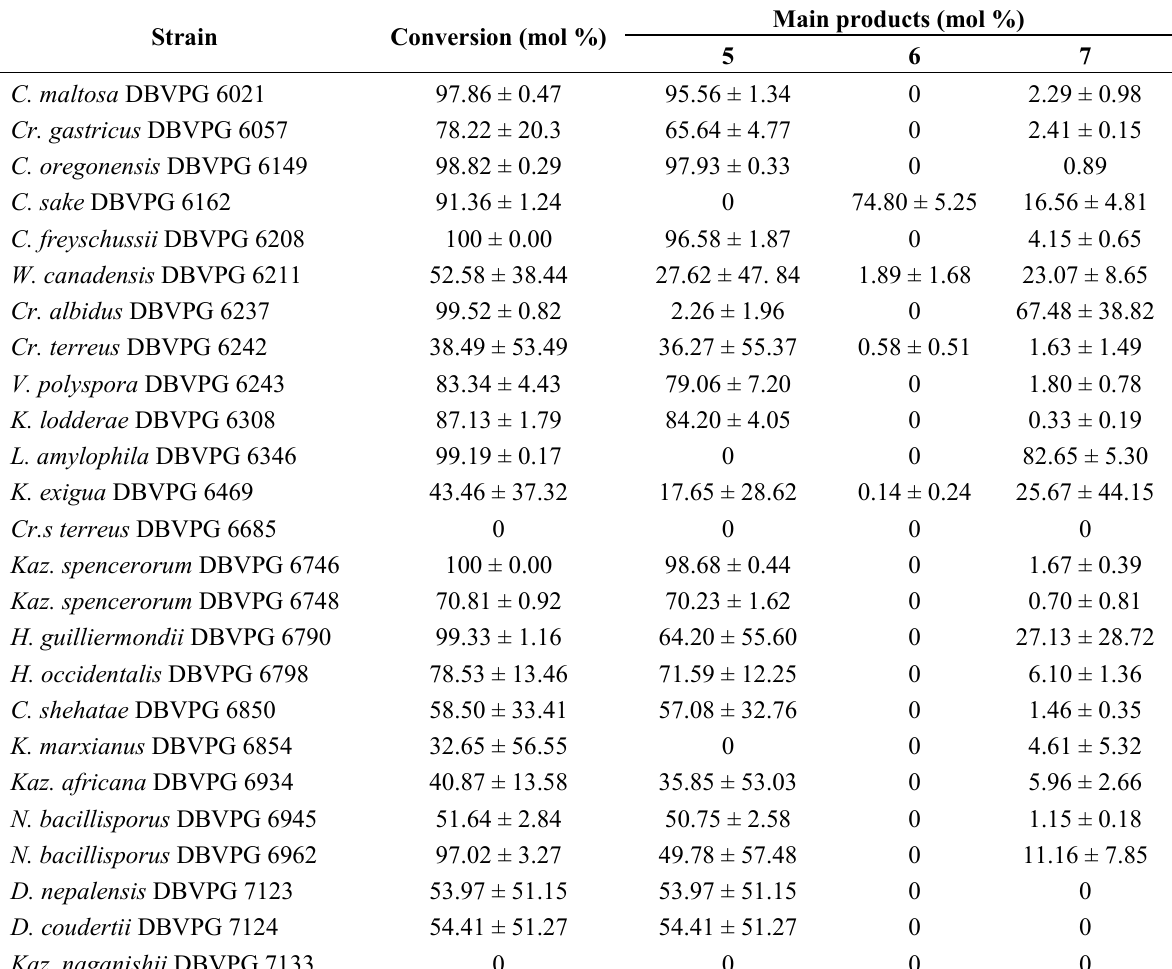
Table 2. Bioconversion of (1 R )-( − )-myrtenal 4 into derivative products after 120 h